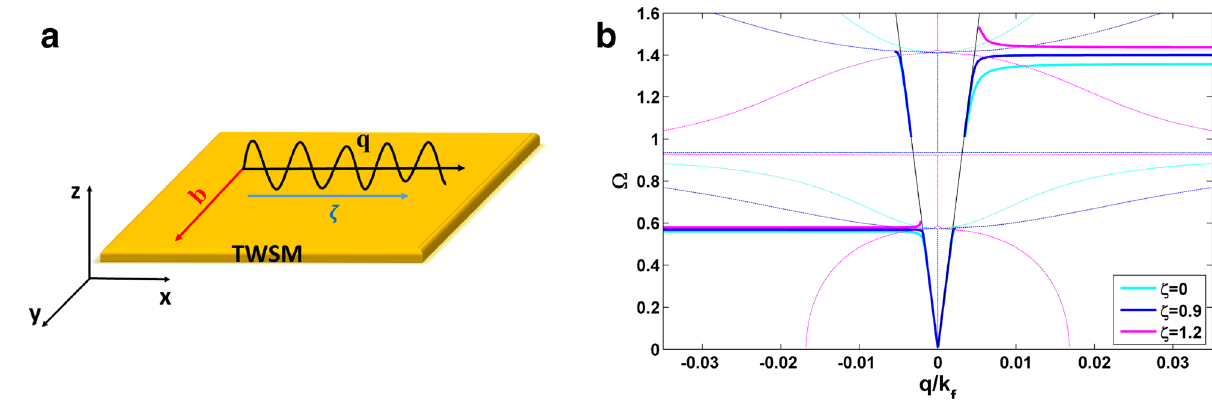
Figure 1. ( a ) Illustration of the Voigt configuration and ( b ) SPP dispersion at the interface of a TWSM and 1 0.57˚A 24 , ε 0 6.2 , ε 3 , 2 b 0.15eV , v 10 6 m/s , g 1 ) with E air ( ε d . The thick (thin) curves − c = f = f = = = = = correspond to SPP (bulk plasmon)